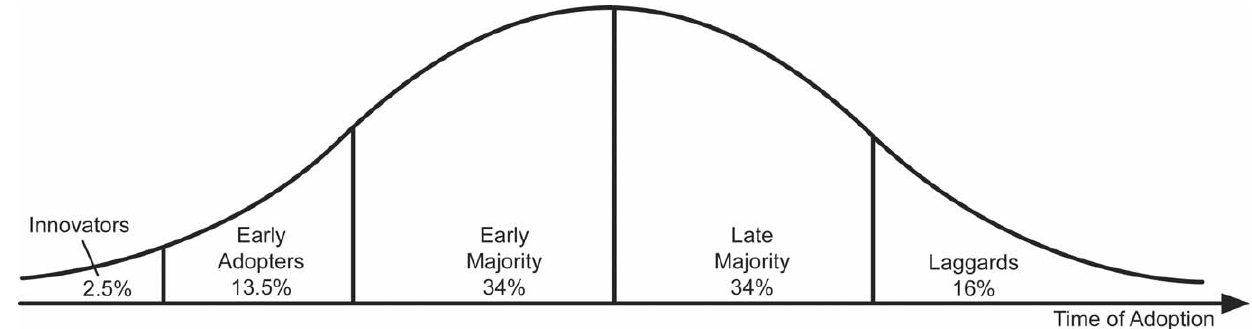
Figure 2. Diffusion of Innovation adoption status. The typical distribution of categories of adopters according to the DOI theory is shown in this figure. The very first adopters or innovators typically represent 2.5% of the population. The next group of adopters, called early adopters, represent about 13.5% of the population and are followed by the early majority, who represent approximately 34% of the total population. The next 34% of the population to adopt are the late majority; this group is followed by the remaining 16% of the population, who are the laggards, the last to adopt a new innovation.